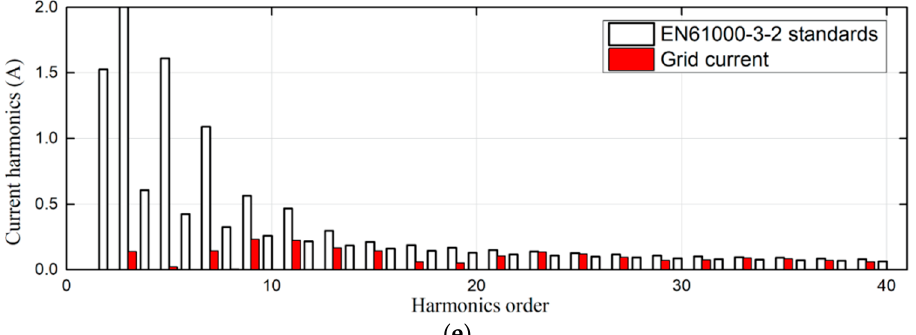
Figure 15. Simulation result of the conventional SMO estimate method with a PI controller: ( a ) Motor Speed; ( b ) Position and estimated error; ( c ) DC-link voltage and grid current; ( d ) Motor output torque; ( e ) FFT analysis of grid current.